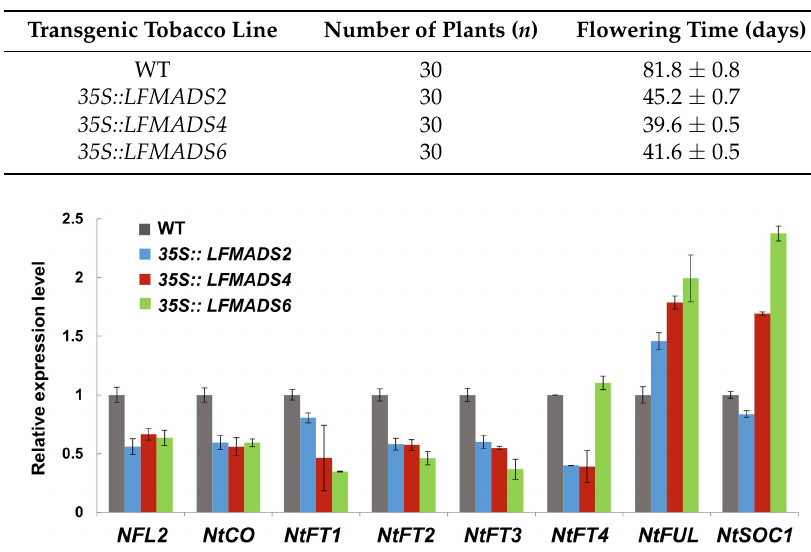
Figure 10. Effect of the overexpressed LFMADS2 , LFMADS4 , and LFMADS6 on the transcript levels of regulatory genes related to the flowering time in tobacco. Relative transcript levels of NFL2 , NtCO , NtFT1 , NtFT2 , NtFT3 , NtFT4 , NtFUL , and NtSOC1 were determined by real-time qPCR analyses of WT and transgenic tobaccos, including 35S::LFMADS2 , 35S::LFMADS4 , and 35S::LFMADS6 seedlings. Each bar represents the average of three replicates and the standard deviation is shown. All the expression levels of each gene were normalized against NteIF4A10 expression. Primers used in qPCR reactions are listed in Table S6.